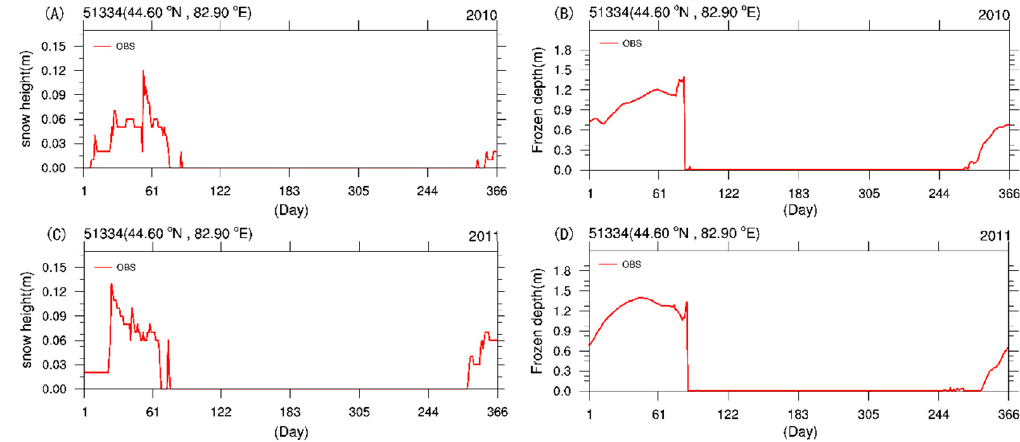
Figure 15. Snow depth and frozen depth values in 2010 and 2011 from the Jinghe Control Station.